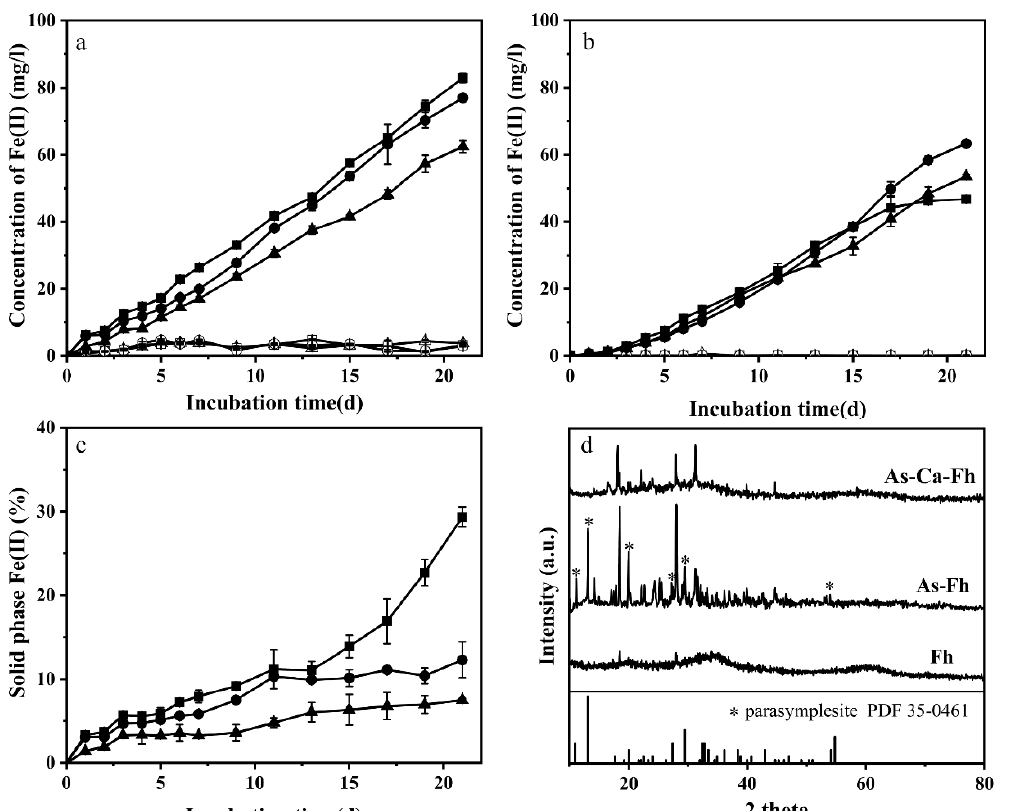
Figure 5. Measured total Fe(II) concentrations ( a ), solution Fe(II) concentration ( b ), proportion of Fe(II) in the solid phase ( c ), and XRD patterns of post-reaction ferrihydrite * stands for parasymplesite ( d ). Triangles ▲ , circles ● , and squares ■ represent Fh, As-Fh, and As-Ca-Fh, respectively, and the corresponding hollow shape represents sterile treatment.